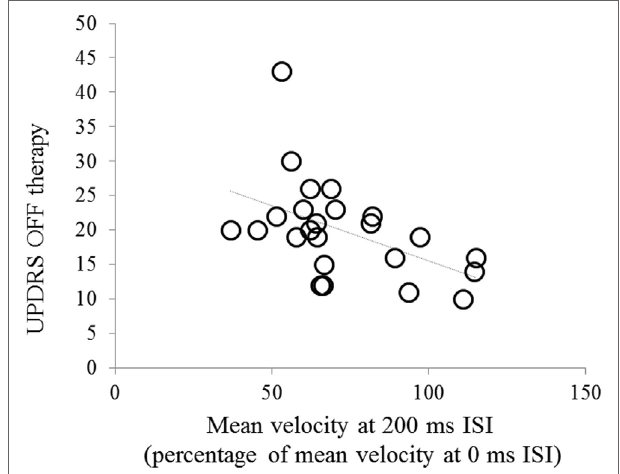
FigUre 3 | Correlation between changes in mean velocity [mean velocity of index finger abductions in the 200 ms interstimulus interval (ISI) trial expressed as percentage of mean velocity at the 0 ms ISI trial] in the more affected hand and UPDRS part III score in the OFF therapy